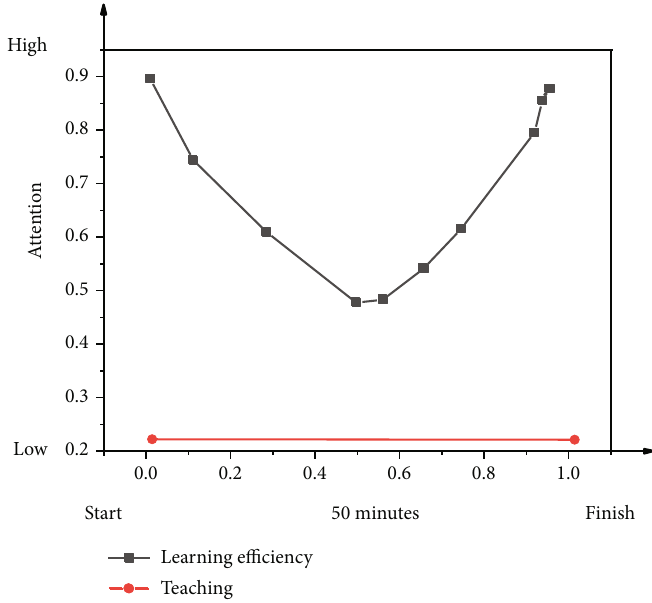
Figure 1: The change of learning e ffi ciency in English class over time.